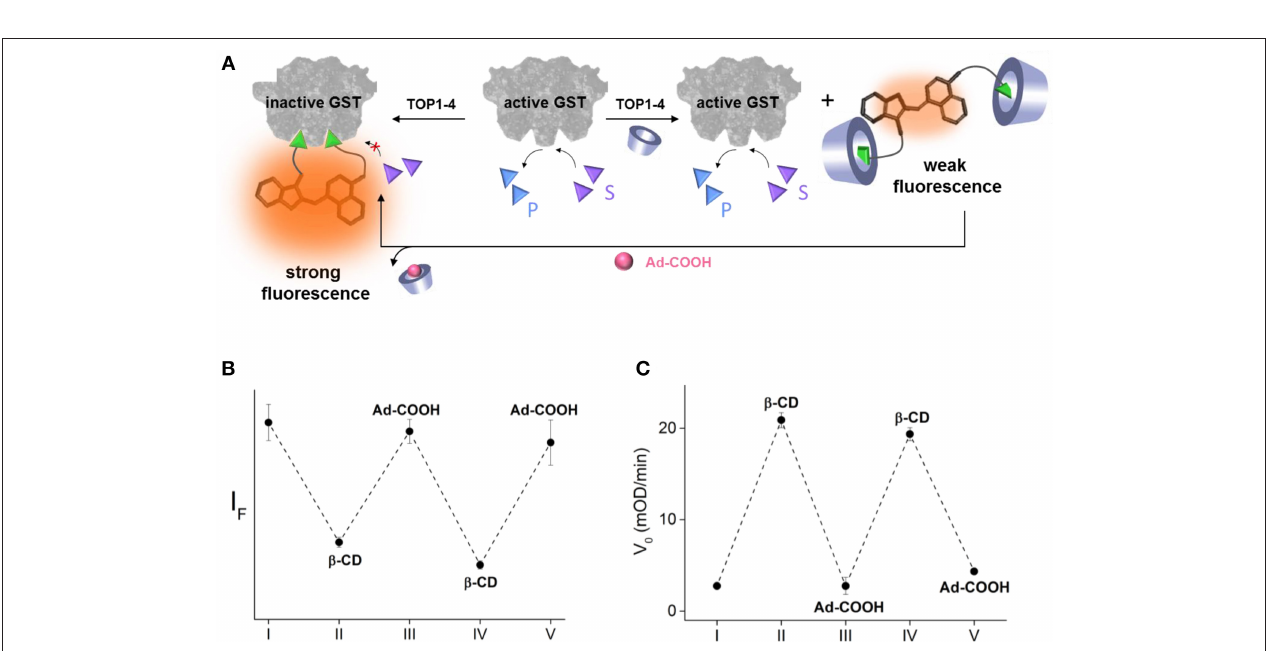
FIGURE 4 | (A) Schematic representation of the way GST activity can be controlled by using Ad-COOH as an additional input that competes with the binding of β -CD to the TOPI-4 inhibitor. (B) Emission intensity measured by combining TOPI-4 with GST-P1-1 and different combinations of β -CD and Ad-COOH: (I) no input, (II) β -CD (1mM), (III) β -CD (1mM) and Ad-COOH (1.5mM), (IV) β -CD (3mM), and Ad-COOH (1.5mM), and (V) β -CD (3mM) and Ad-COOH (5mM). (C) Initial velocity (V 0 ) measured by combining TOPI-4 with GST-P1-1 and different combinations of β -CD and Ad-COOH: (I) no input, (II) β -CD (800 µ M), (III) β -CD (800 µ M), and Ad-COOH (1mM), (IV) β -CD (2.5mM) and Ad-COOH (1mM), and (V) β -CD (2.5mM) and Ad-COOH (3.3mM). λ ex / λ em =